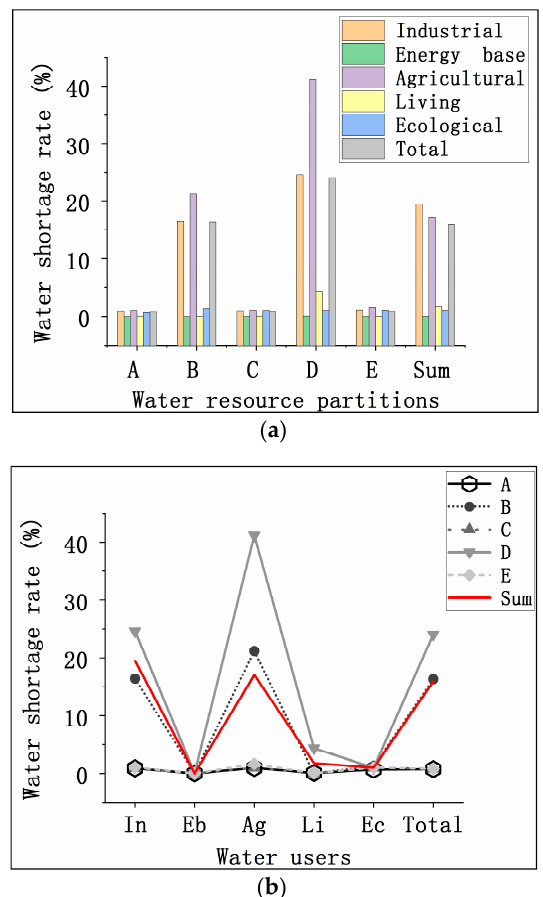
Figure 8. ( a ) Different water resource partitions, ( b ) different water users. Water shortage rate Figure 8. ( a ) Di ff erent water resource partitions, ( b ) di ff erent water users. Water shortage